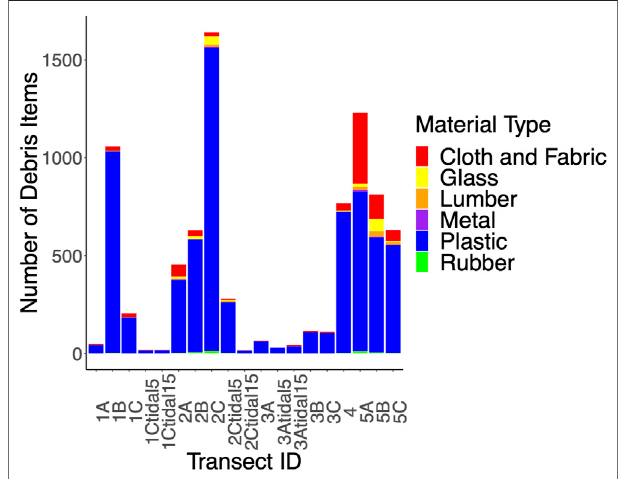
FIGURE 2 | Bar graph showing the total amount of items of anthropogenicdebrisperm 2 surveyedineachtransectwithinall fi vesites.The colorsrepresentthe proportion ofeach material type surveyed inthe